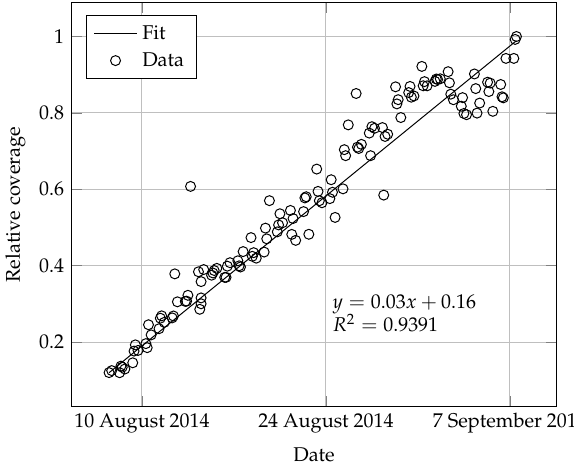
Figure 13. Fractional vegetation cover over time using Lytro LF image files and a green filtering algorithm in MATLAB.